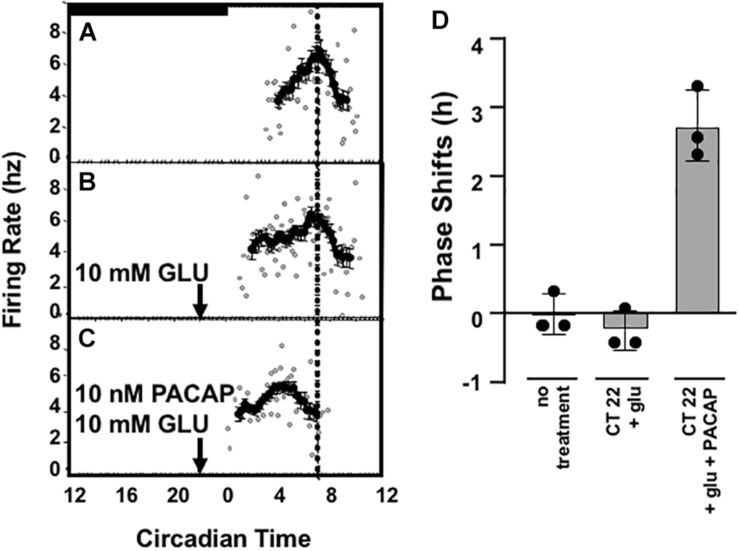
Summary of PACAP dependence of late-night phase advance in slices from enucleated wild-type C57Bl/6 mice. Panels (A–C) depict PACAP dependence of glutamate-induced late-night phase advance using the doses of glutamate and PACAP shown to best mimick physiological phase-advance (i.e., phase advance observed in vivo in C57Bl6 mice). Panel (D) summarizes the phase shift data obtained from preparations from three separate animals for each treatment condition. In enucleated mice, treatment with glutamate + PACAP is significantly induced as compared to no treatment or with glutamate alone. p < 0.001, One-way ANOVA, Tukey post-hoc test.